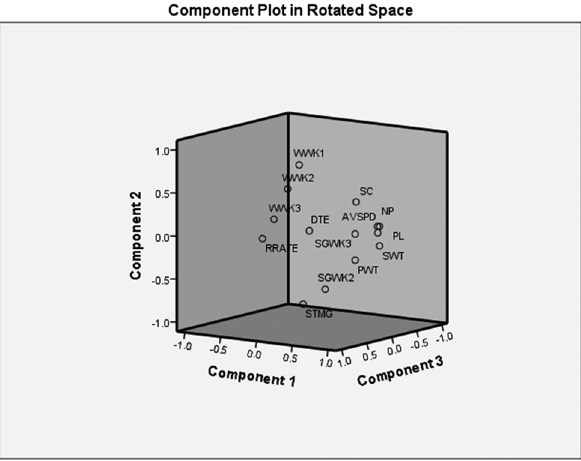
Figure 2: Component plot in rotated space showing contributions of principal component variables. SGK1 – stem greenness in week 1; SGWK2 – stem greenness in week 2; SGWK3 – stem greenness in week 3; WWK1 – wilting in week 1; WWK2 – wilting in week 2; WWK 3 – wilting in week 3; SC – survival count; RR – recovery rate; NP – number of pods; SP – seeds per pod; PL – pod length; PWT – pod weight; and SWT – seed